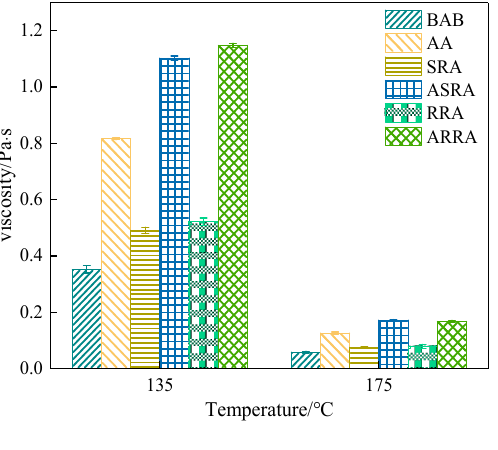
Figure 2. Viscosity.